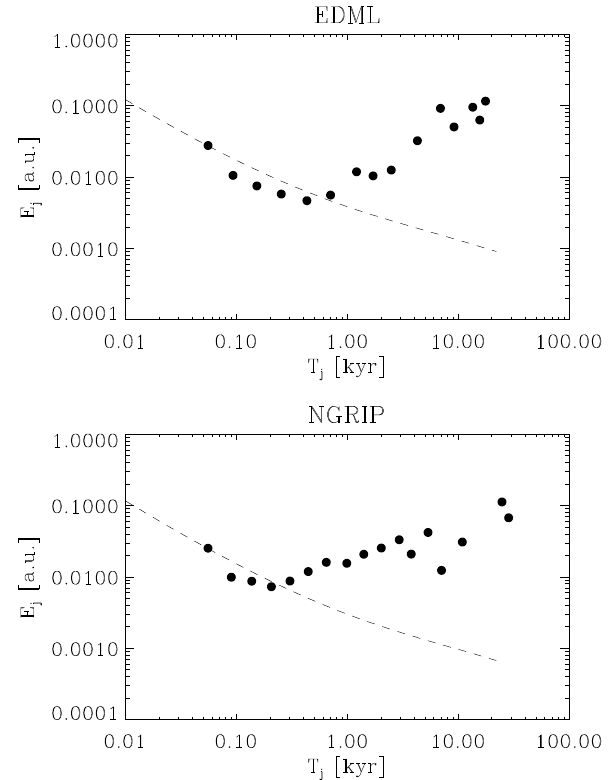
Figure 4. Normalized IMF square amplitude E j vs. the period T j for the EMD significance test applied to the EDML (upper panel) Fig. 4. Normalized IMF square amplitude E j vs. the period T j for and NGRIP (lower panel) IMFs. The dashed lines represent the 99th the EMD significance test applied to the EDML (upper panel) and percentile (see the text for details). NGRIP (lower panel) IMFs. The dashed lines represent the 99th Fig. 4. Normalized IMF square amplitude E j vs. the period T j for percentile (see the text for details). the EMD significance test applied to the EDML (upper panel) and NGRIP (lower panel) IMFs. The dashed lines represent the 99th percentile (see the text for details).